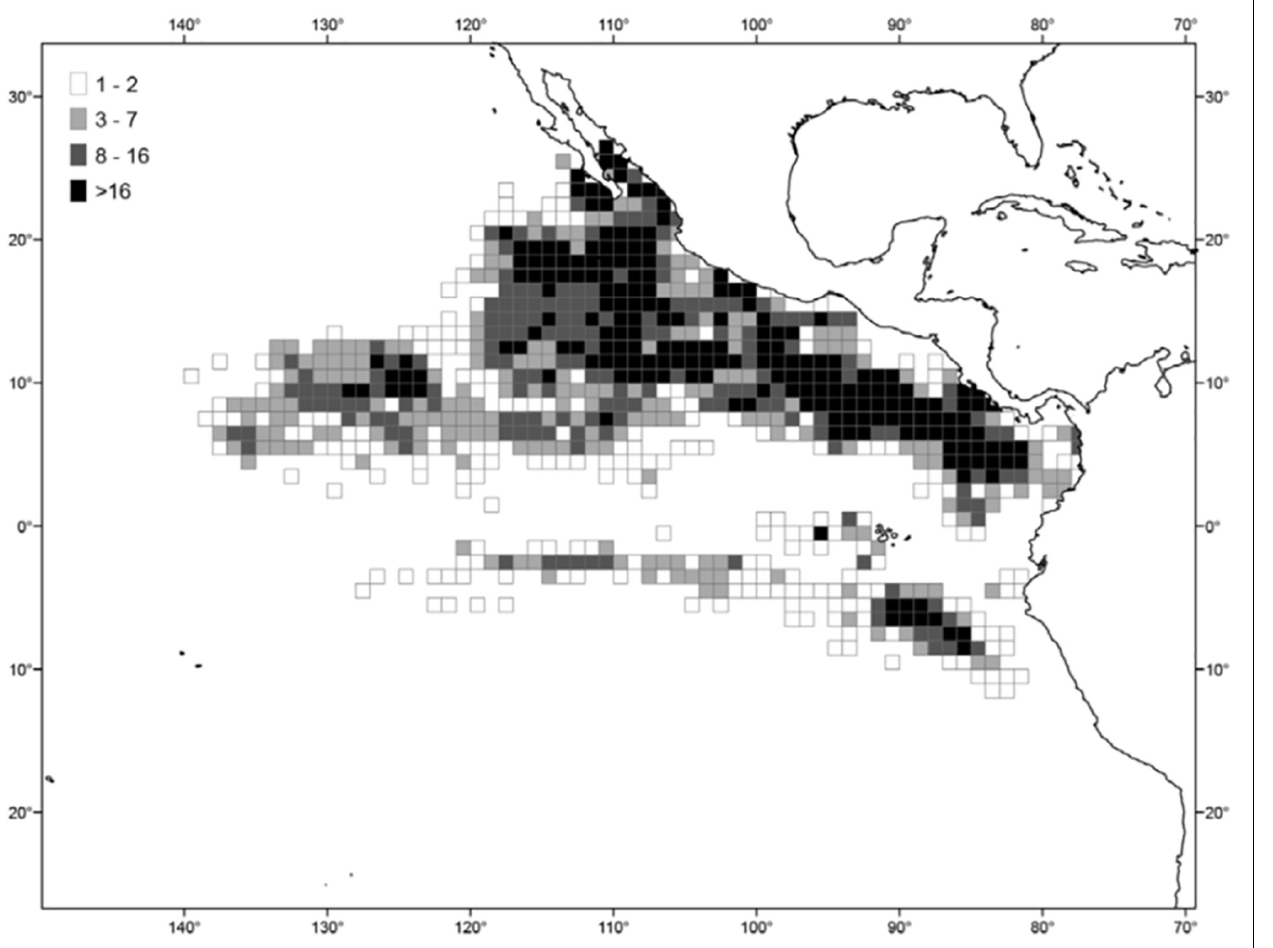
FIGURE 4 | A wide-ranging fishery—distribution of purse-seine sets on dolphins during 2010 in the eastern tropical Pacific; a total of 11,645 sets are shown (Source: Inter-American Tropical Tuna Commission [IATTC],